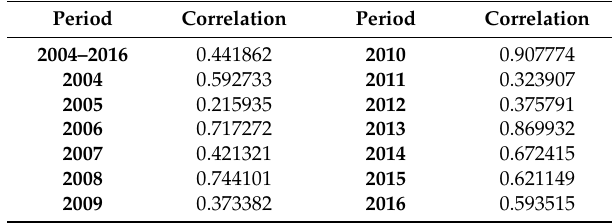
Figure 4. Price-to-book value indexes. Table 7. Correlation between price-to-book based index.